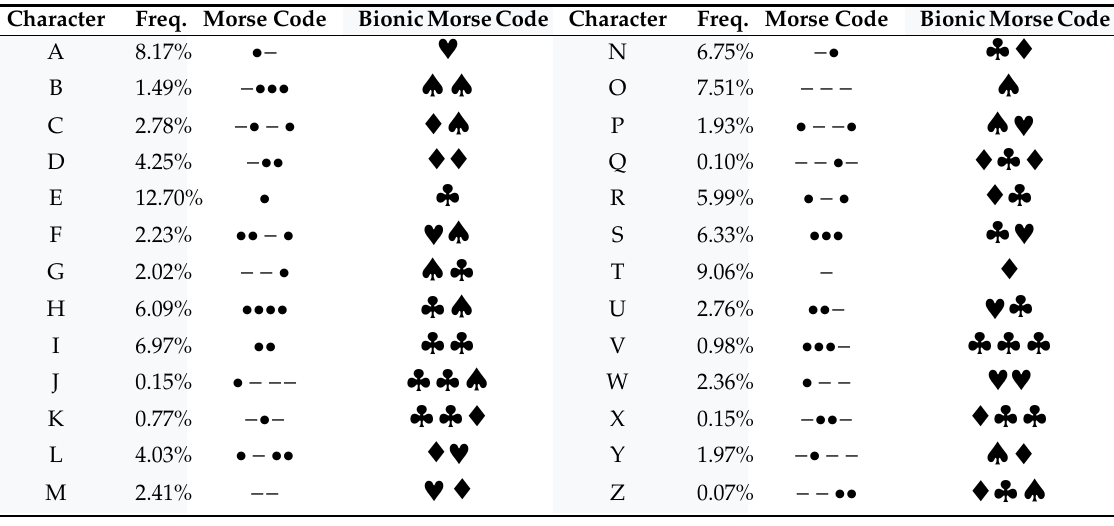
Table 1. Representation of English language characters through Morse and bionic Morse codes.